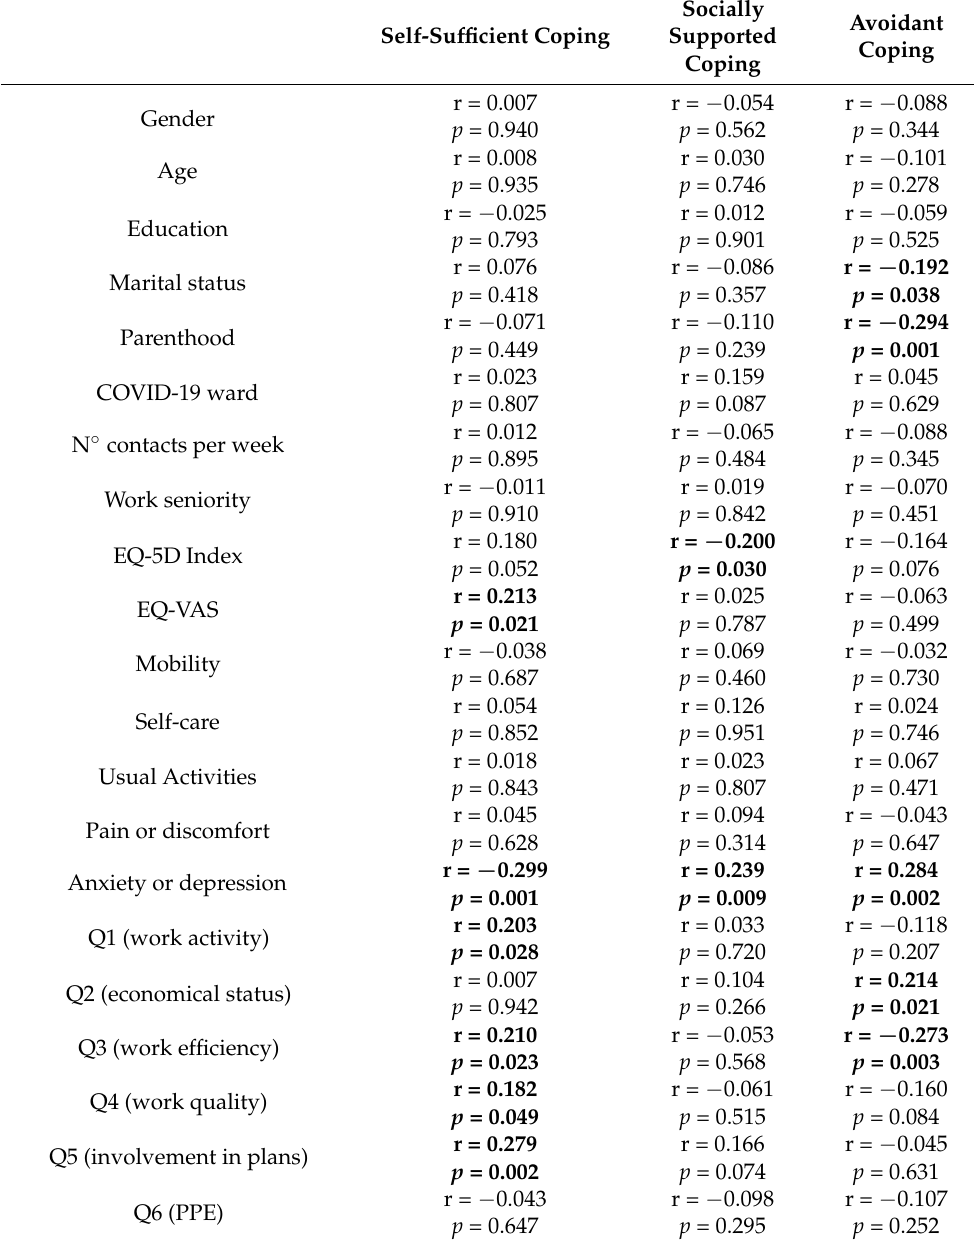
Table 6. Correlation matrix between Brief-COPE and sociodemographic characteristics, work-related factors, European Quality of Life, and work environment perception in group P. Socially Self-Sufficient Coping